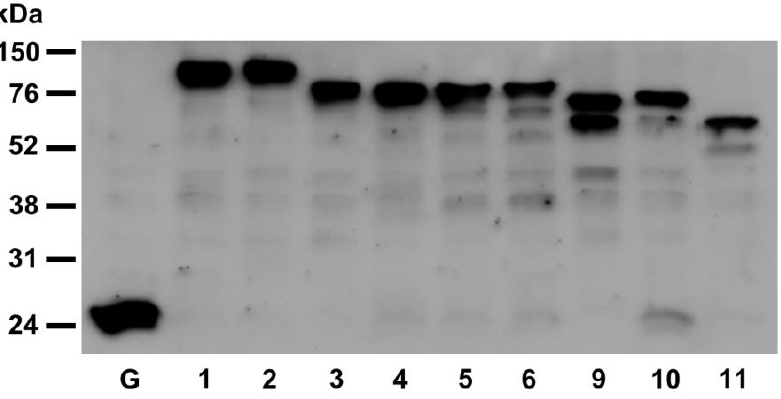
Figure 7. Western blot analysis of PDI-GFP fusions expressed in Arabidopsis leaf protoplasts. Crude protein extracts were obtained from Arabidopsis leaf protoplasts transfected with constructs expressing GFP(S65T) alone (control) or fused to members of the Arabidopsis PDI family. The proteins were immobilized on a nitrocellulose membrane and GFP was detected using a rabbit anti-GFP primary antiserum, and an anti-rabbit horseradish peroxidase conjugated secondary antiserum. G, GFP(S65T); 1, PDI1-GFP-KDEL; 2, PDI2-GFP-KDEL; 3, PDI3-GFP-KDEL; 4, PDI4-GFP-KDEL; 5, PDI5-GFP-KDEL; 6, PDI6-GFP-KDEL; PDI9-GFP-KDEL; 10, PDI10-GFP-KDDL; 11,